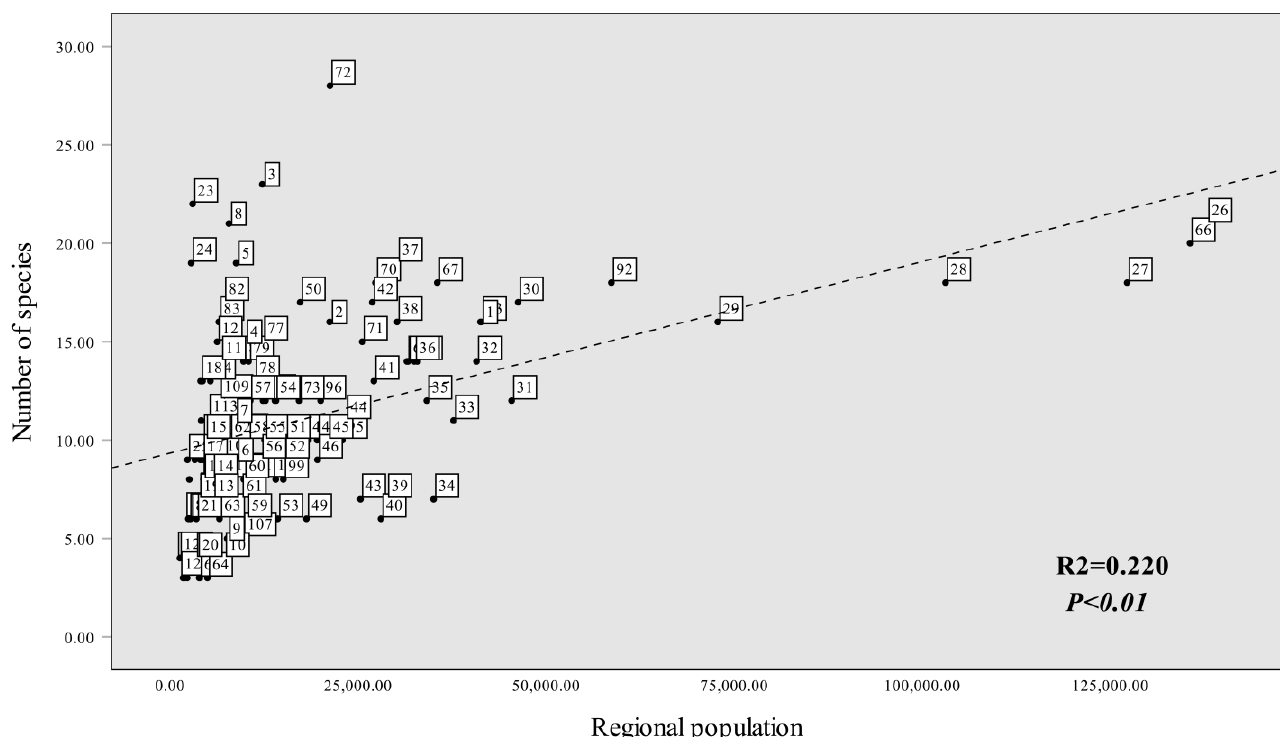
Figure 5. Correlation analysis between regional population (number of individuals) and IAS (number of species). Different positions represent different counties (e.g., position 3 represents Xiuqi town).